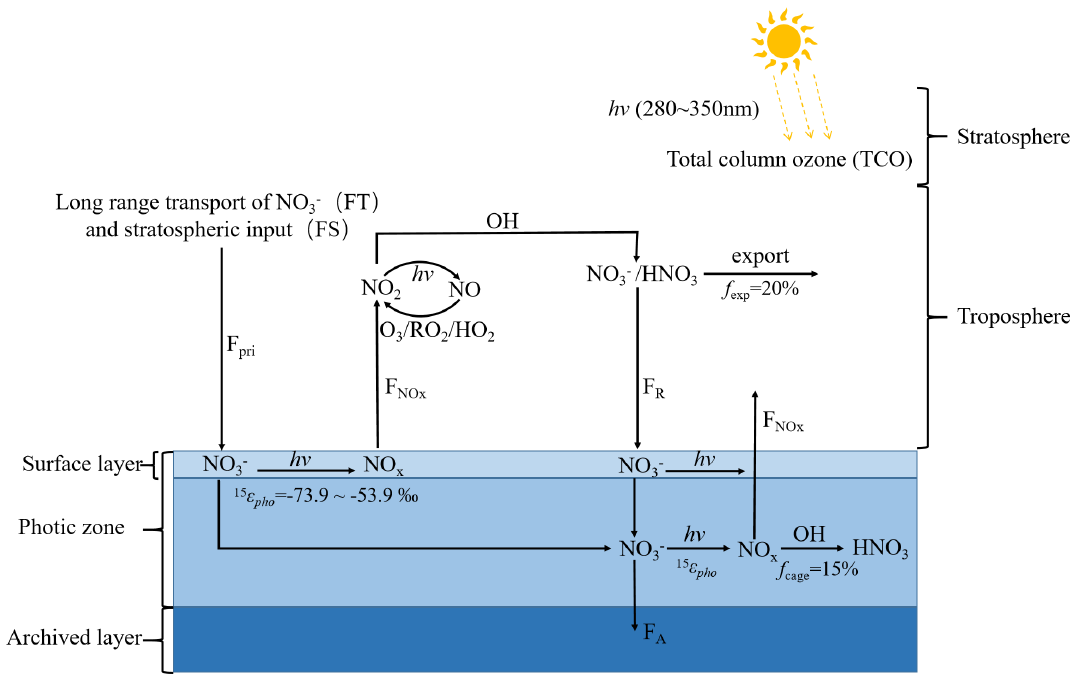
Figure 2. Schematic diagram of the photo-driven post-depositional processing of snow nitrate (adapted from Zatko et al., 2016 and Geng, 2022). Details on abbreviations can be found in Table S2.